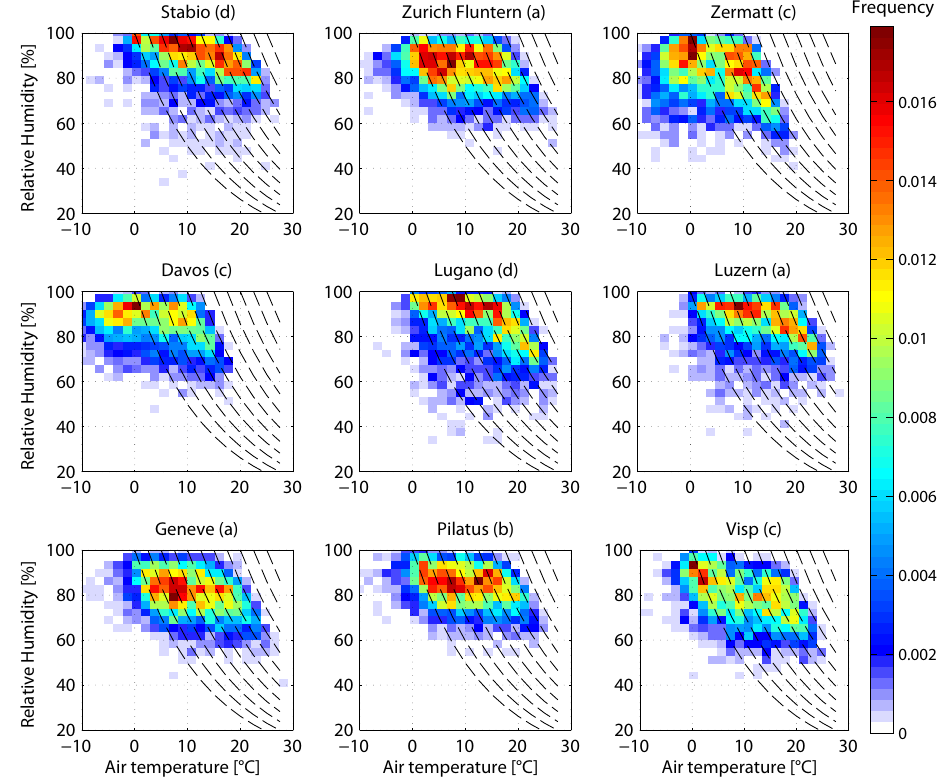
Figure 9. Relative frequency of mean daily relative humidity as a function of mean daily air temperature for wet days (precipitation higher than 1mmday − 1 ) at nine representative stations in the four regions in our data set: (a) Plateau, (b) pre-Alps, (c) Alps, (d) Tessin. Constant vapour pressure curves are shown with dashed lines.